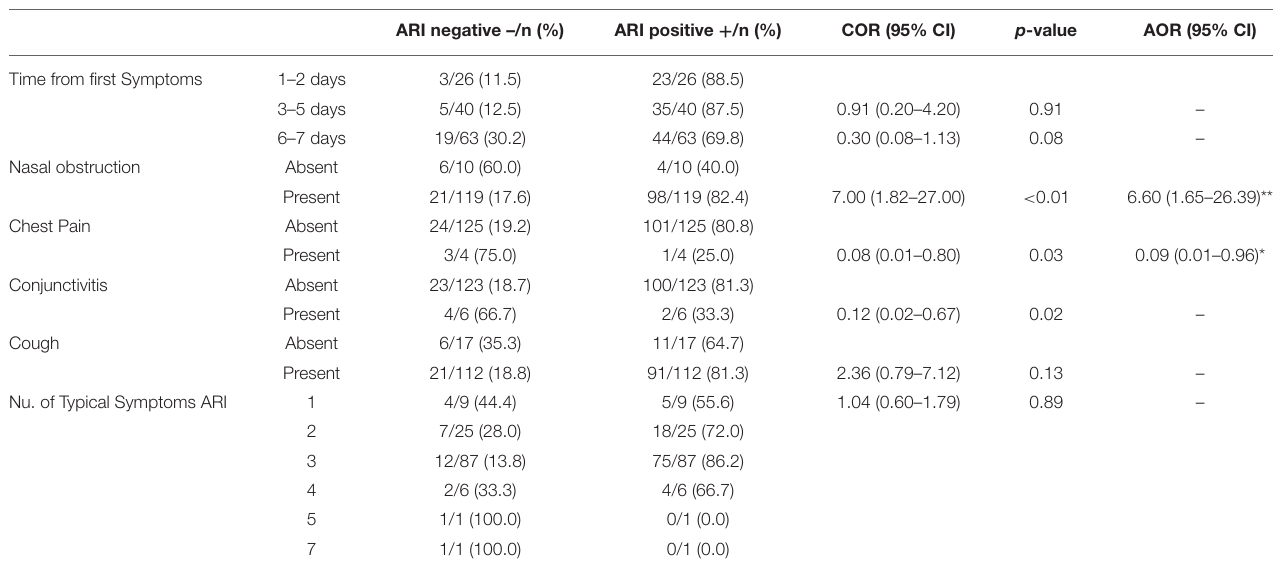
TABLE 3 | Relation between Symptoms and